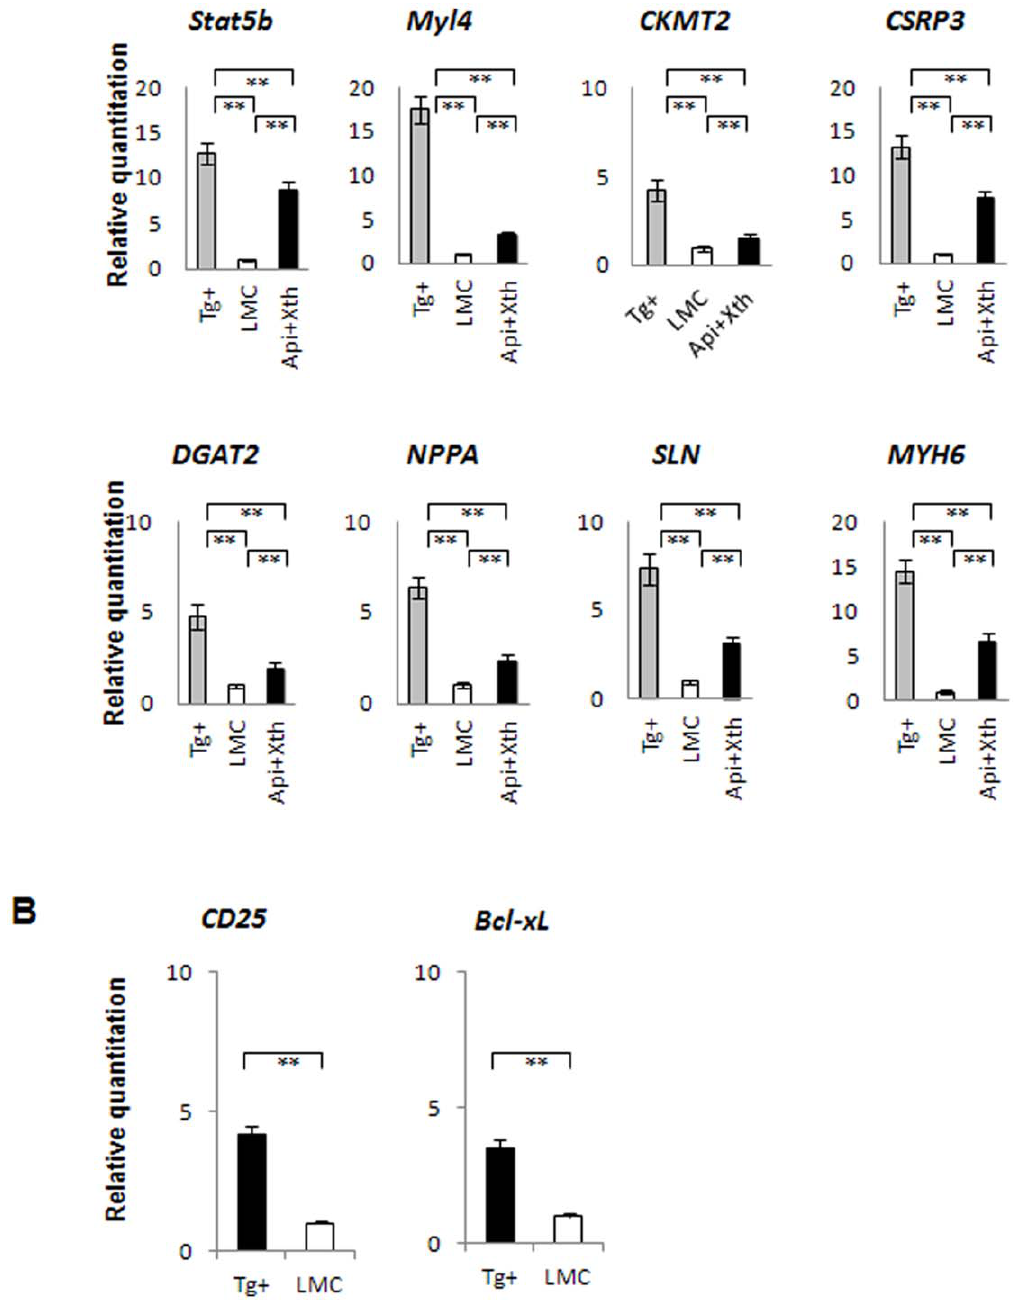
Figure 5. Up-regulation of gene expression in NOD.Stat5b Tg mice. (A)Real-time RT-PCR was used to analyze RNA from thymus of NOD.Stat5b Tg (Tg + ) mice and their littermate controls (LMC) (4 weeks of age) as well as NOD.Stat5b Tg mice after treatment with both Apigenin and Xanthohumol (Api + XN). RNA concentration was normalized with GAPDH. (B) Real-time RT-PCR was used to analyze RNA from thymus of NOD.Stat5b Tg (Tg + ) mice and their littermate controls (LMC) (8 weeks of age). Data from LMC were arbitrarily set to ‘‘1’’ for easier comparison. **, P , 0.01, compared with that of littermate controls.